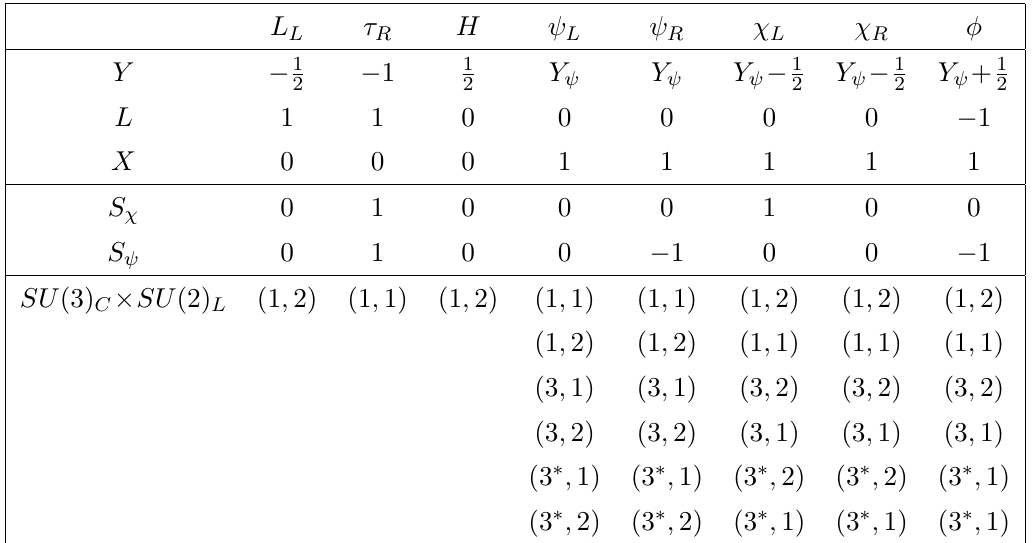
Table 6. Quantum numbers of fields for Class 2 τ -lepton models. The last six lines list the models containing only singlets and fundamentals under the SM gauge